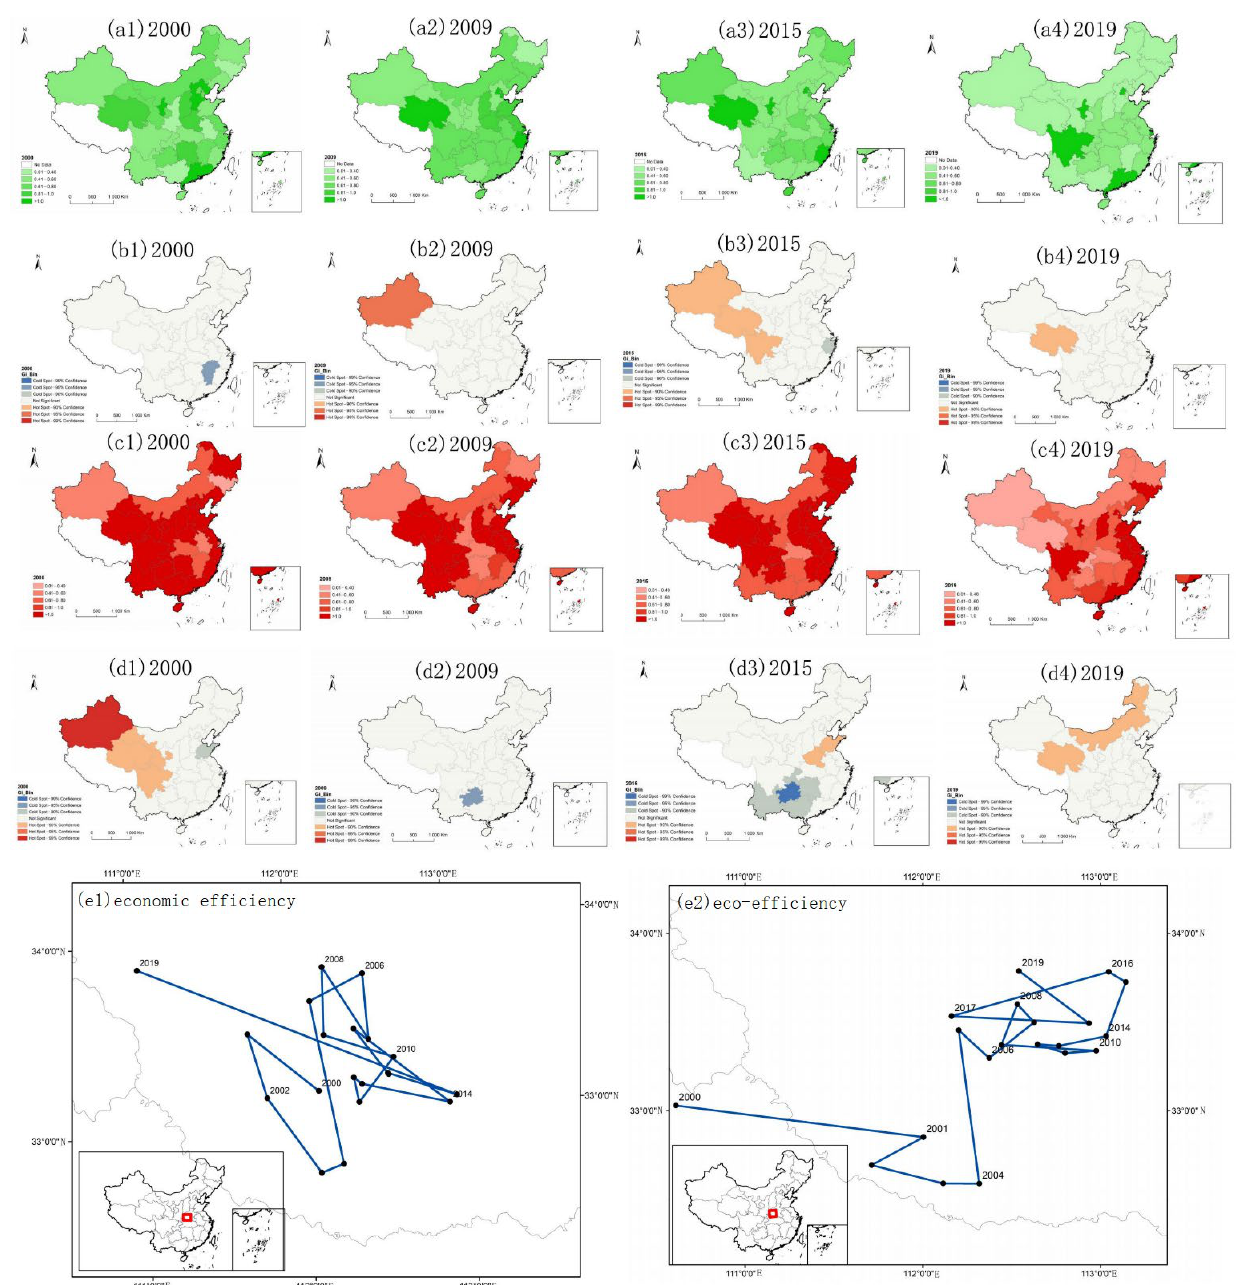
transitional area with insignificant correlation, which indicates that the spatial aggregation effect of eco-efficiency of tourist hotels in China is not significant.